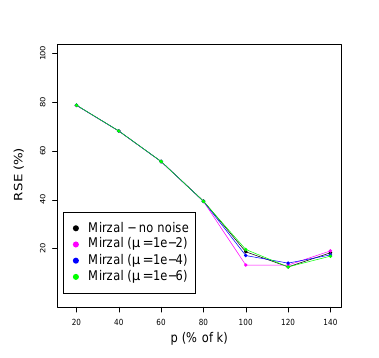
Values of RSE for Algorithm 1 for n = 200, for the original and the noisy BION data.